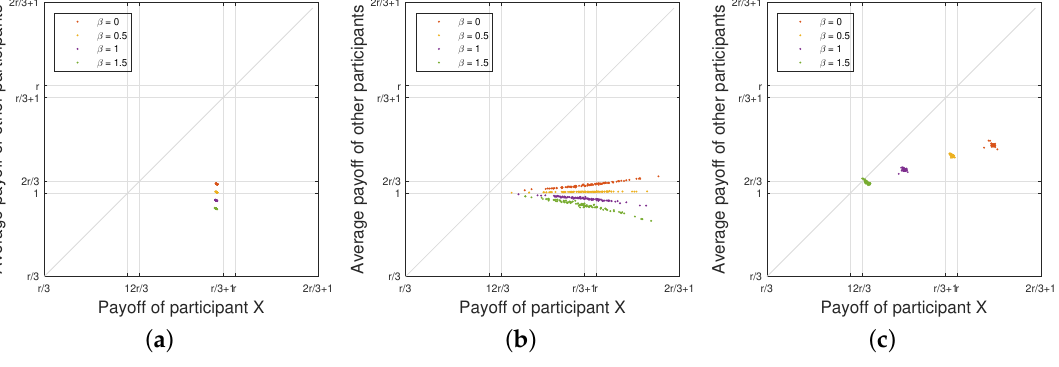
Figure 6. The payoff of the extortion strategy versus other strategies. ( a ) Extortion versus WSLS Strategy; ( b ) Extortion versus Random Strategy; ( c ) Extortion versus Equalizer